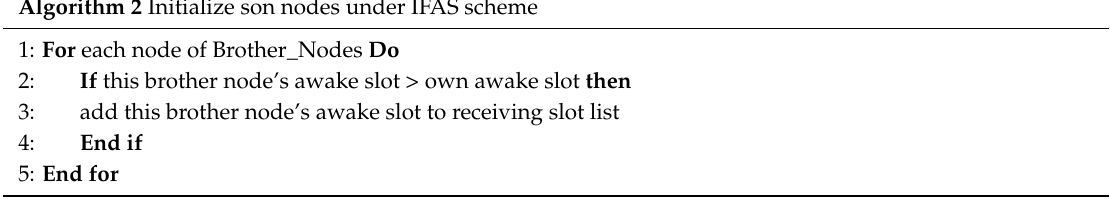
Algorithm 2 Initialize son nodes under IFAS scheme